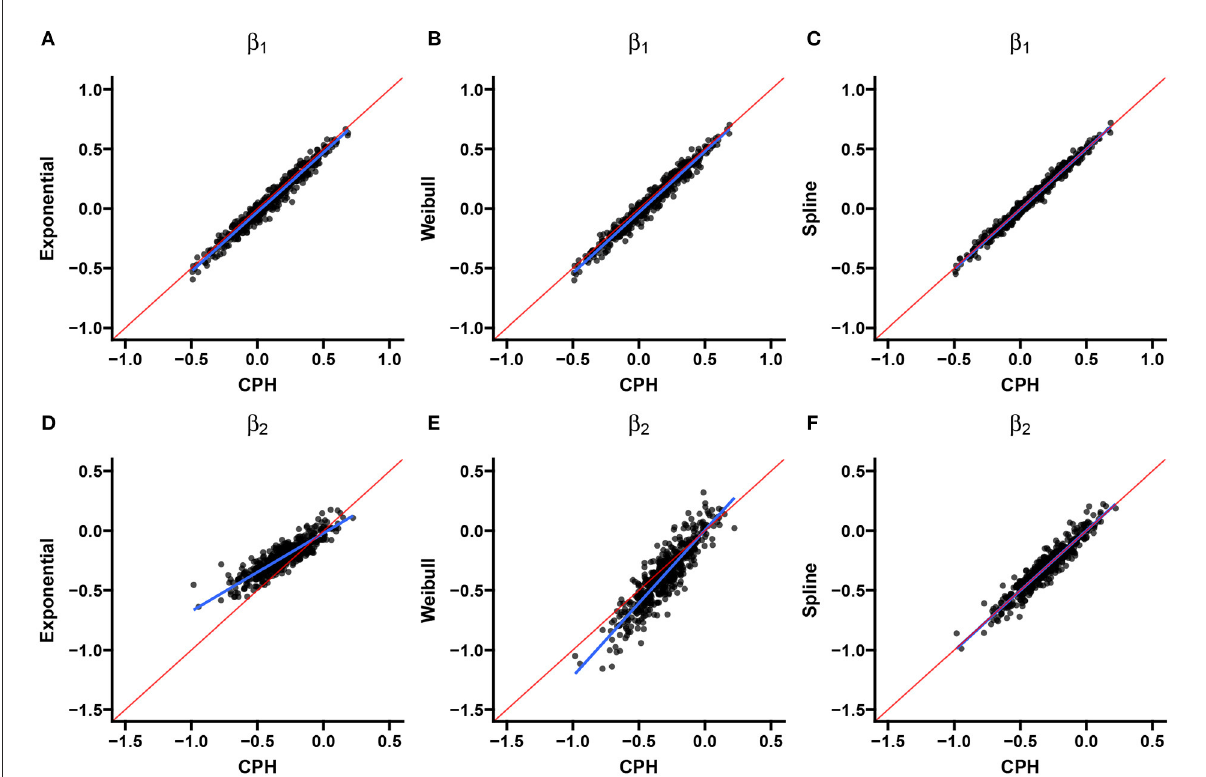
FIGURE4 Scenario 1: Correlation with CPH estimates. Scatterplots show the correlation between estimates from the exponential (A,D) , Weibull (B,E) , and spline models (C,F) for the event of interest (A–C) and the competing/clearance event (D–F) with estimates from the CPH model using exact time data. The blue line is the simple regression line and the red line is the identity